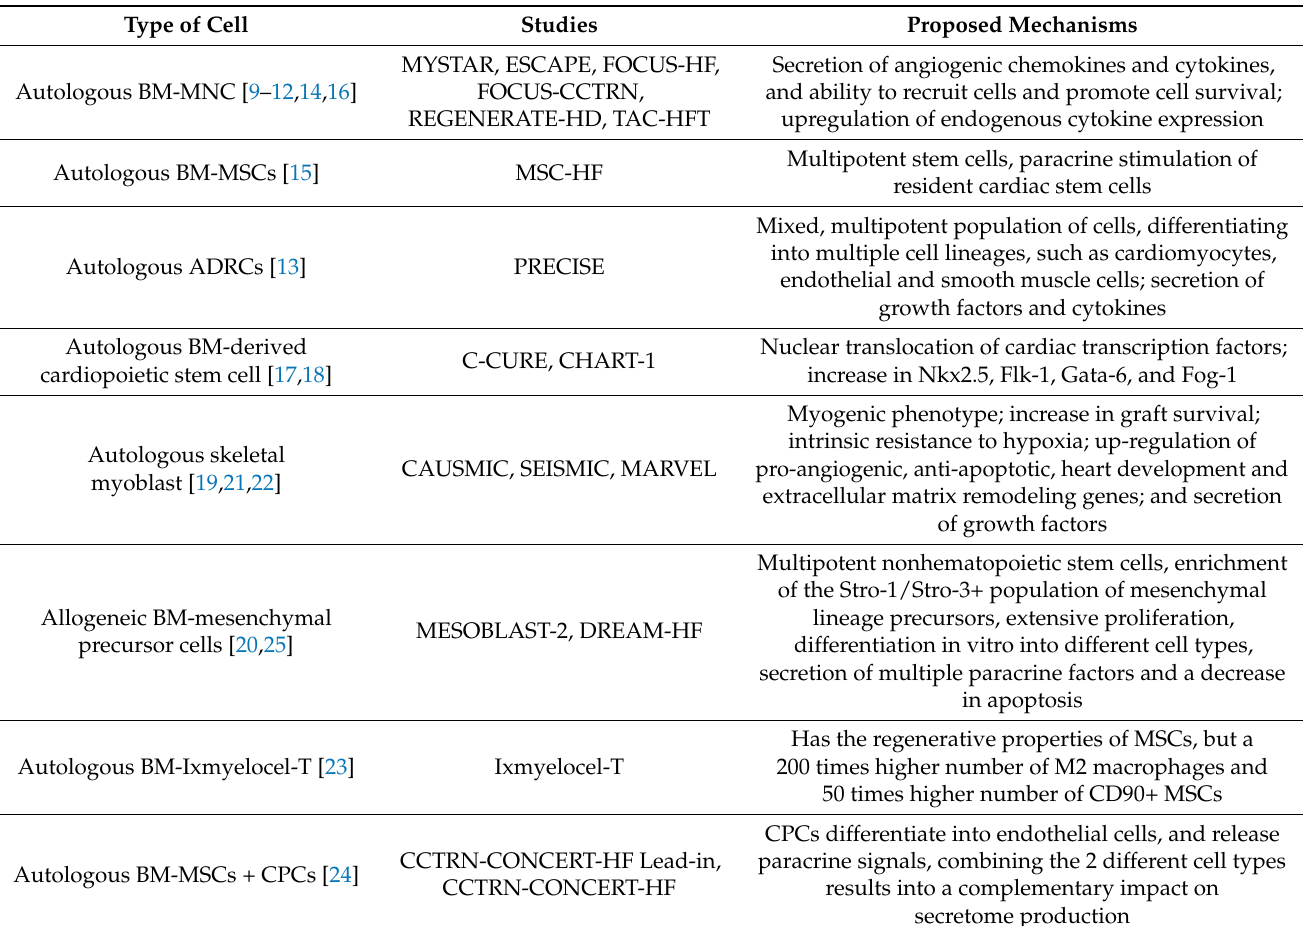
Table 6. Proposed mechanisms of the different cell